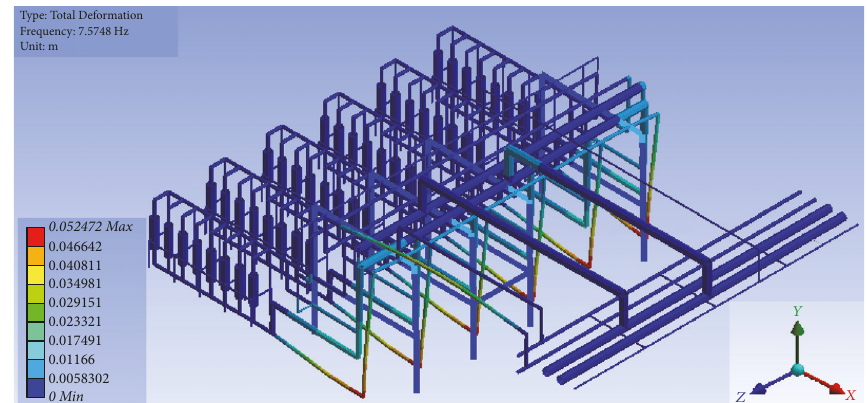
Figure 17: Vibration mode of 2nd modal order.